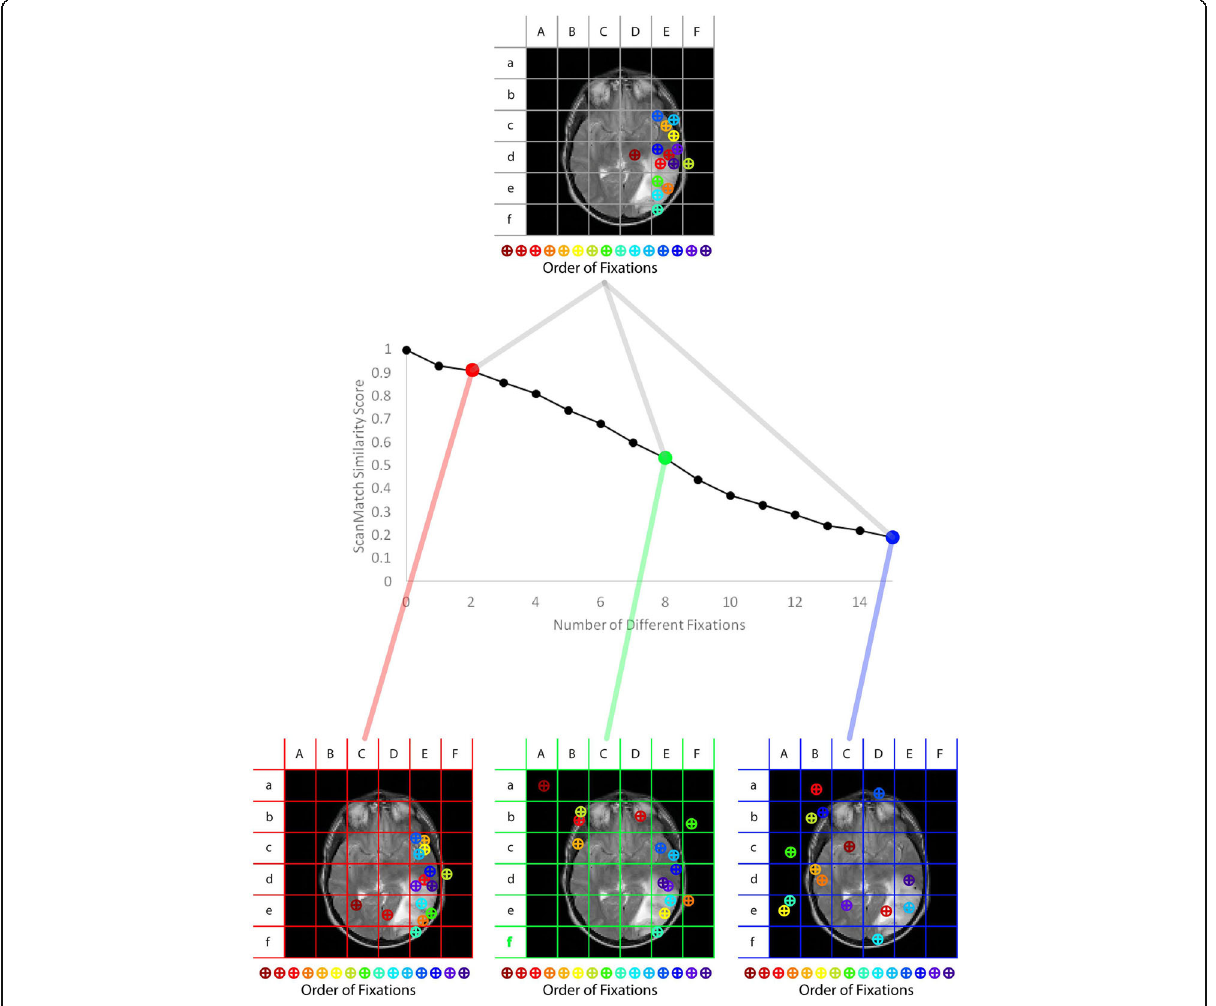
Fig. 3 An illustration of the relationship between scanning sequences and ScanMatch similarity scores. The top panels show the scanning sequence of a Participant N (note fixations are plotted according to the correct ROIs not the specific fixation location for presentation purposes). The middle panel shows the effect number of different fixations between two sequences on ScanMatch similarity score. The bottom panel shows scanning sequences that have 2 (red), 8 (green) and 15 (blue) random fixations inserted into the scanning sequence of Participant N to show the effect of this on ScanMatch similarity score